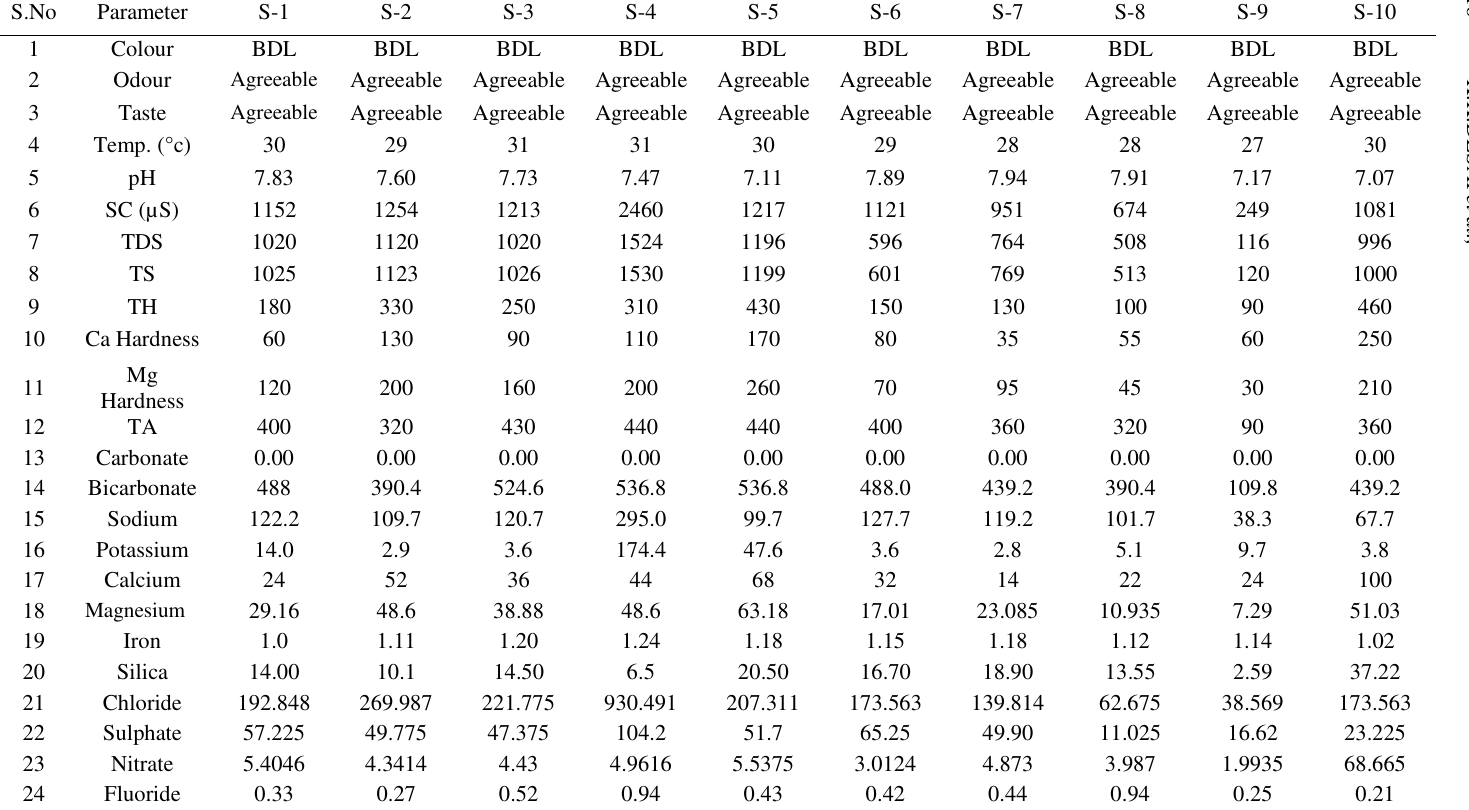
Table-1 Physico-chemical analysis report of Potable waters in MAY-2004